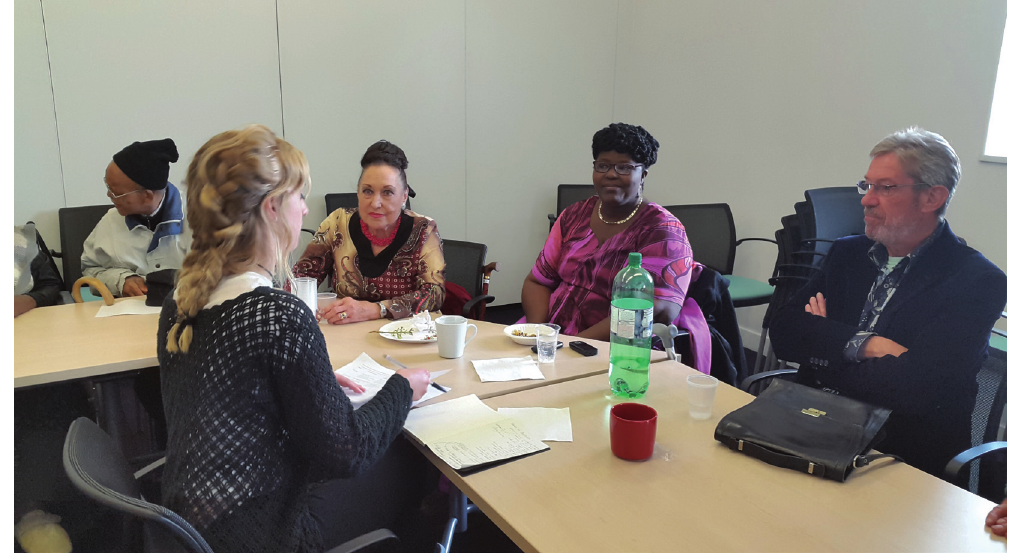
Figure 7: The student artists at a Stroke Research Patients and Family Group meeting